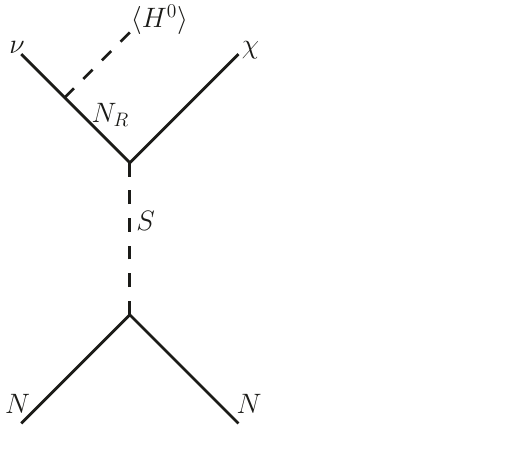
Figure 6 . The process for CE (cid:23)N S in the UV complete realization given in section 3.1. a modi(cid:12)ed type-I seesaw mechanism [51{54]. This means that we would require at